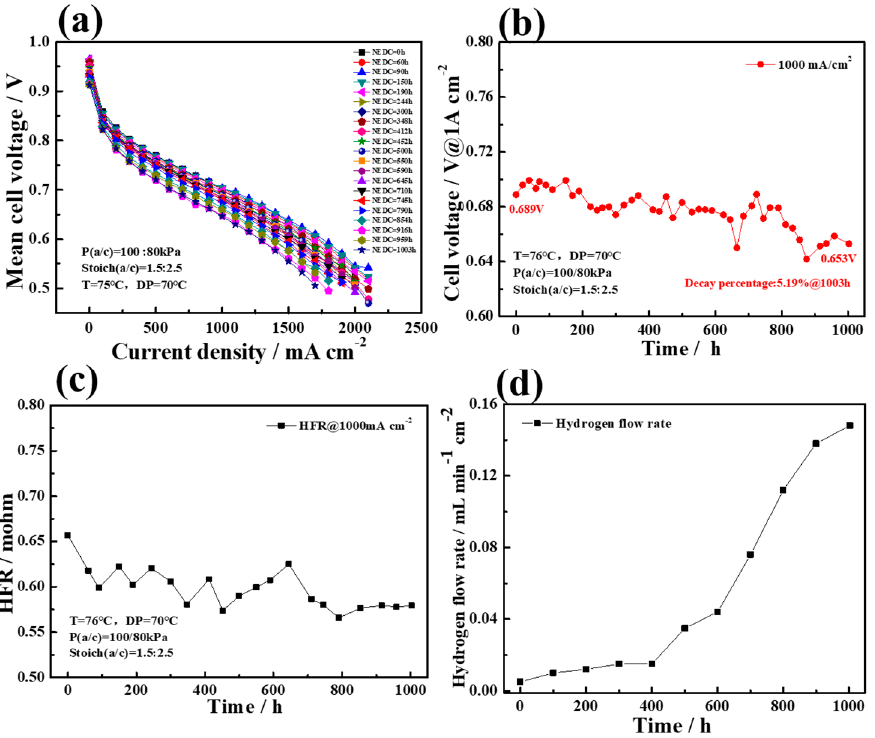
Figure 8. ( a ) Polarization curves during durability test, ( b ) the change of mean cell voltage, ( c ) the change of HFR, and ( d ) the change of H 2 crossover flow rate during the durability test.